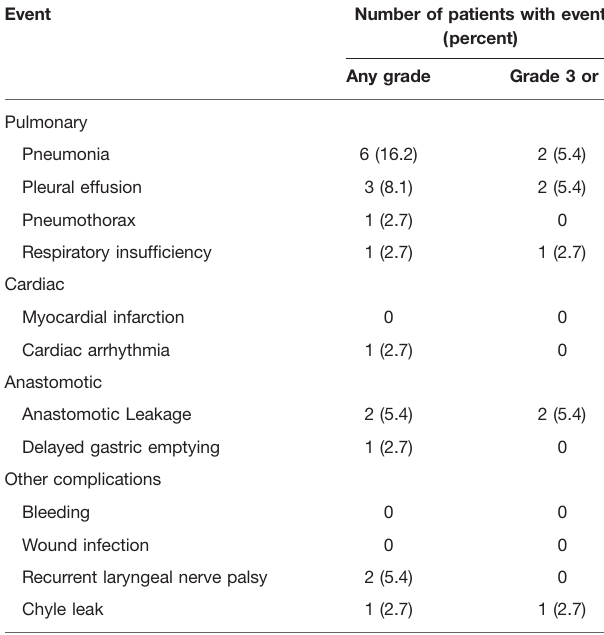
TABLE 3 | Thirty-day complications ( n